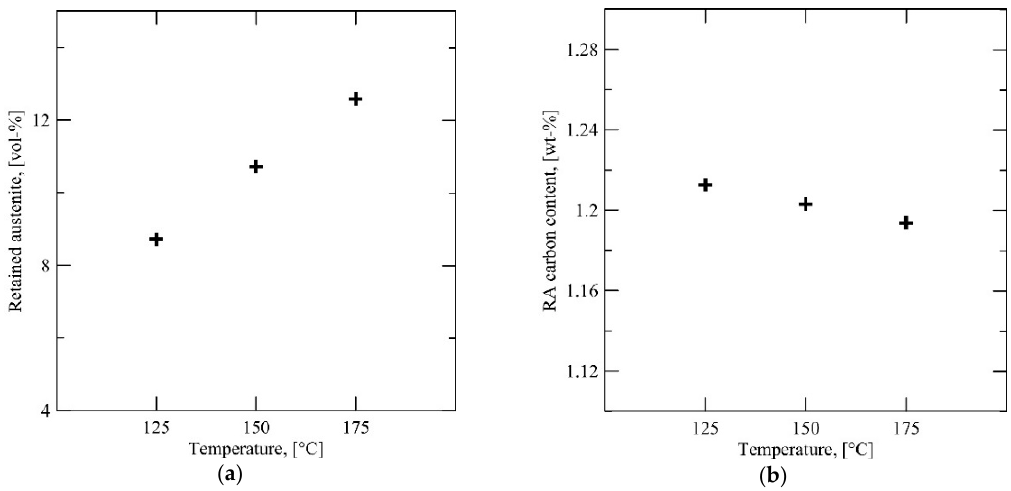
Figure 6. ( a ) The retained austenite fraction of Steel A with respect to initial quench temperature QT . ( b ) The carbon content of the retained austenite with respect to QT . Specimens annealed at 850 °C, quenched to QT and partitioned at 450 °C for 100 s.